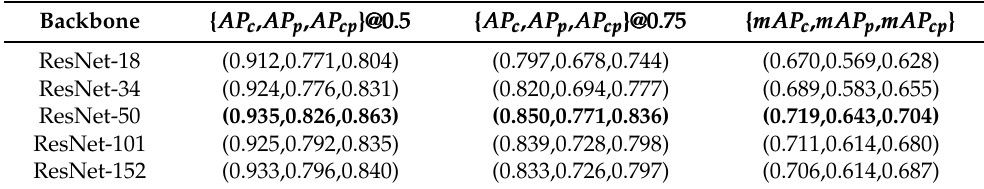
Table 5. Illustration of how the AP metrics of IPH-TOOD change with regard to the depth of the backbone network on the IPHPDT dataset.